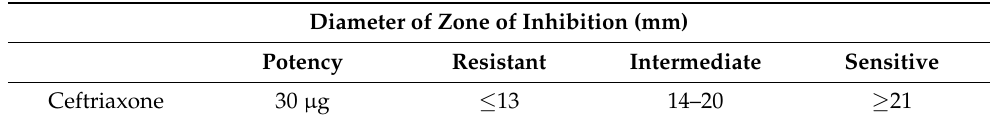
Table 3. Diameter of inhibition zone interpretative criteria for S. aureus . Diameter of Zone of Inhibition (mm) Potency